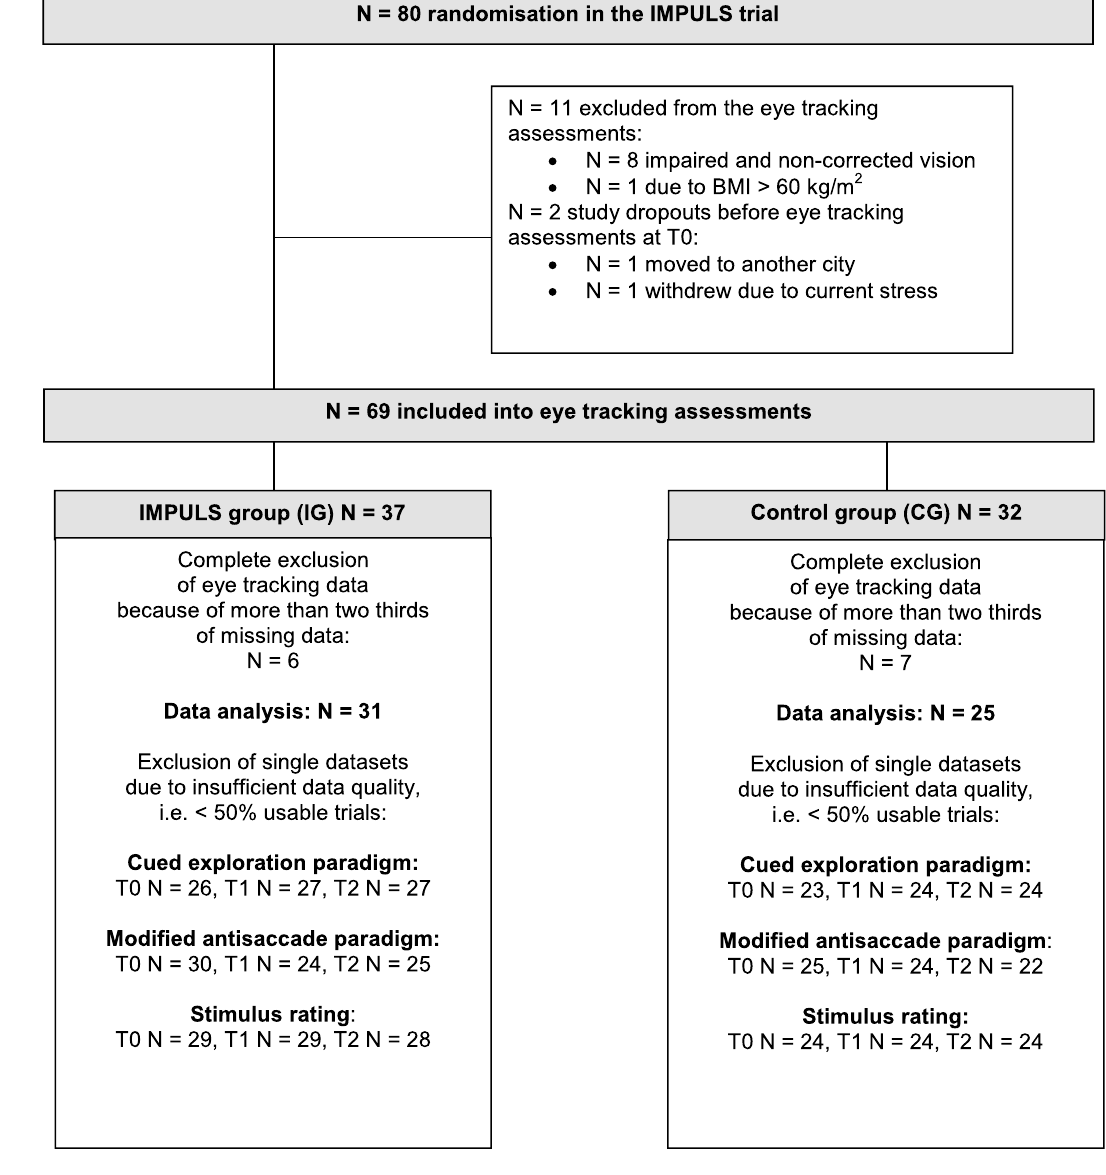
Figure 1. Patient flow chart of the eye tracking analysis in the IMPULS